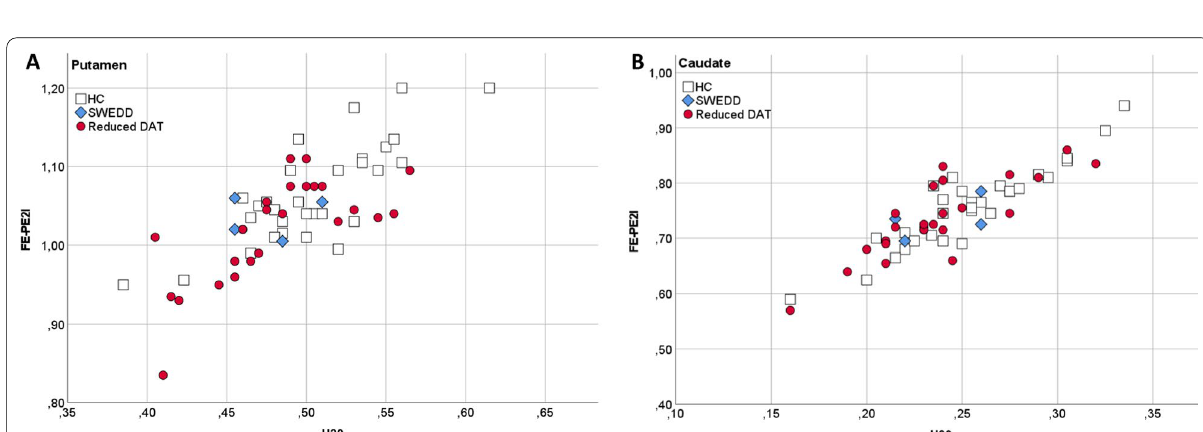
Fig. 4 Relative regional cerebral blood flow (rCBF R ) in relation to striatal DAT activity. Legend Plots illustrating the relationship between rCBF R in ( A ) putamen and ( B ) the caudate, measured by R1 (FE-PE2I) and F (H 2 O) and striatal DAT activity. Red circles: patients with pathologically reduced striatal DAT uptake. Blue rhombs: patients without signs of dopaminergic deficit, “SWEDD” (i.e., normal striatal DAT activity). Open squares: healthy controls (HC) with normal DAT activity in the